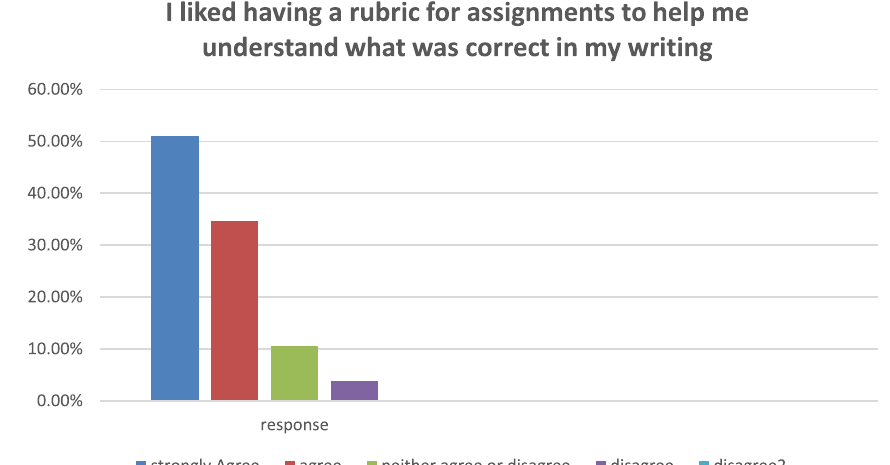
Rubric informs expectations of instructor